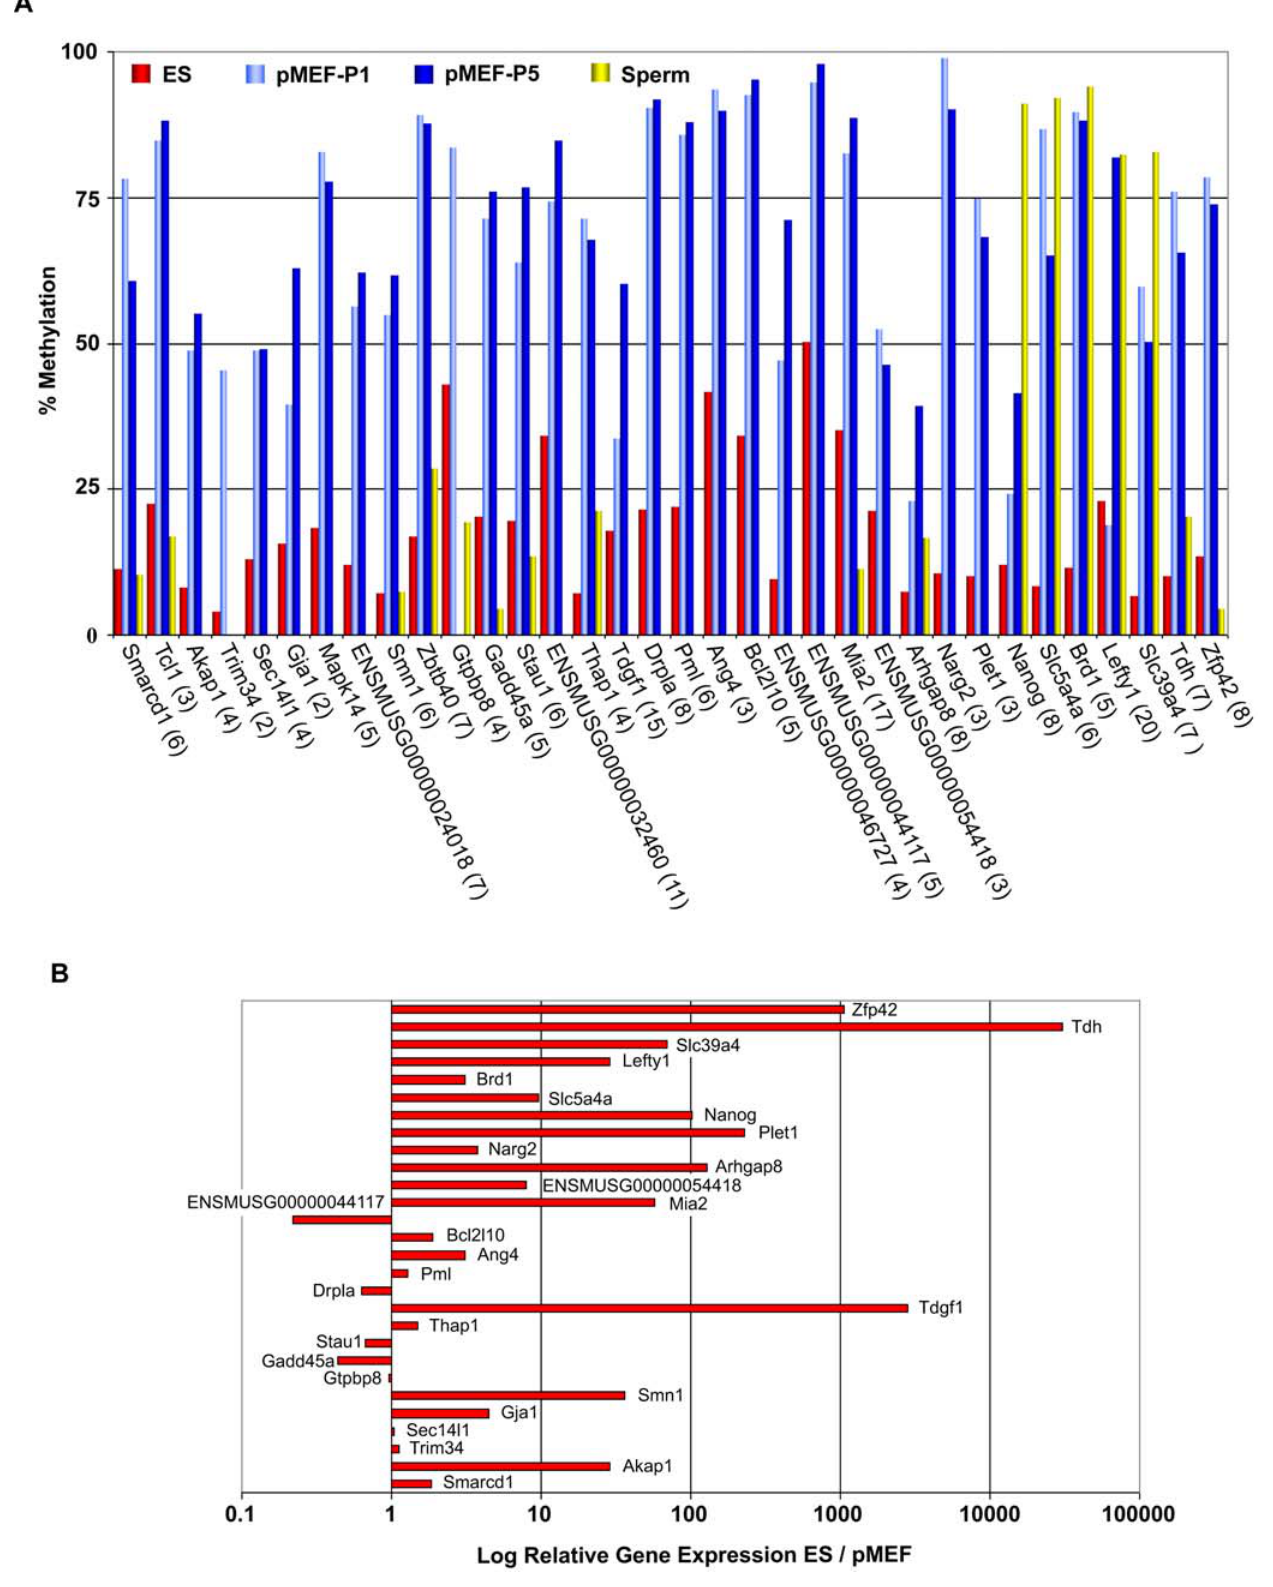
Figure 3. Promoter methylation and gene expression compared between ES cells and pMEFs. (A) Promoter methylation patterns in ES cells (red bars), early passage pMEFs (pMEFs-P1, light blue bars), late passage pMEFs (pMEFs-P5, dark blue bars) and sperm (yellow bars). Candidate promoter regions were identified by the meDIP screen and validated by Sequenom analysis. The number of differentially methylated CpGs analysed for each gene are given in brackets. (B) Gene expression differences between ES cells and pMEFs (P1) as determined by quantitative RT-PCR analysis. The x -axis gives the log-fold expression difference between the cell types (i.e., log [ ES / pMEF ]). Three reference genes ( Dynein , Rsp23 and Hdac10-11 ) were used for normalization between cell types. doi:10.1371/journal.pgen.1000116.g003 PLoS Genetics |